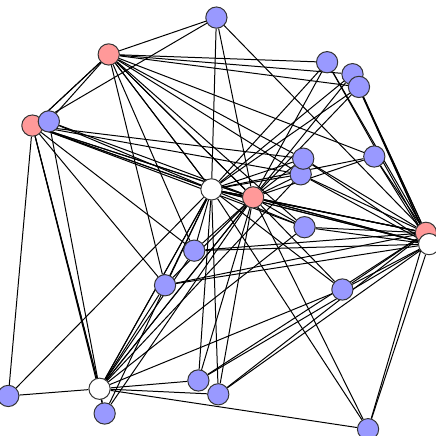
Figure 2. A medium network example.